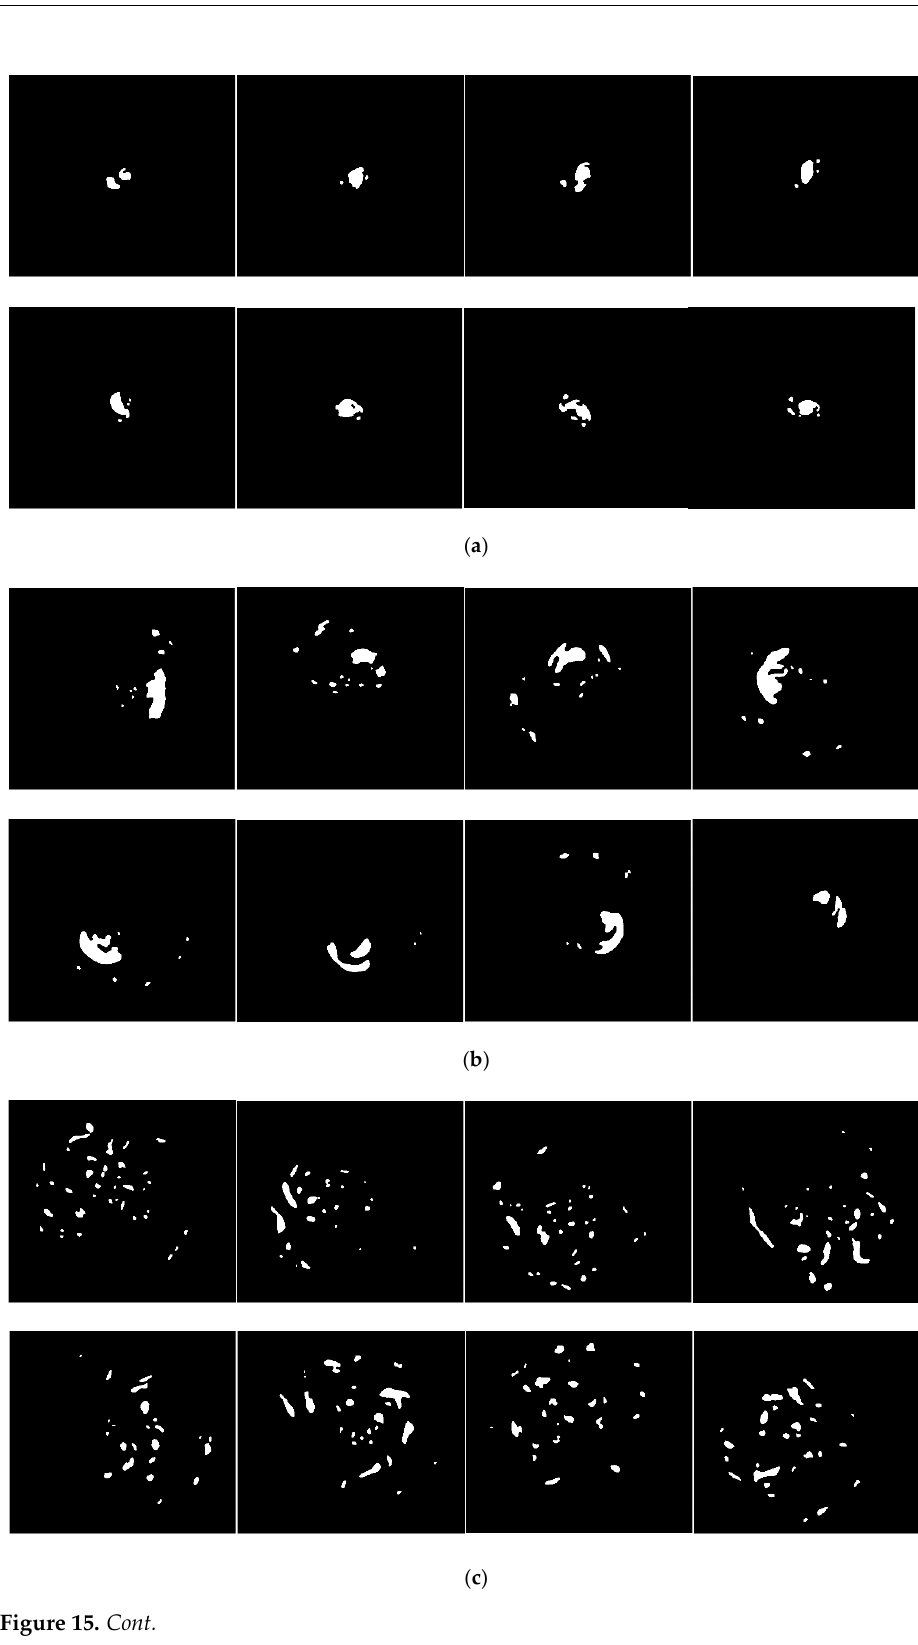
Figure 14. Shape of vortex rope at eight continuous moments.